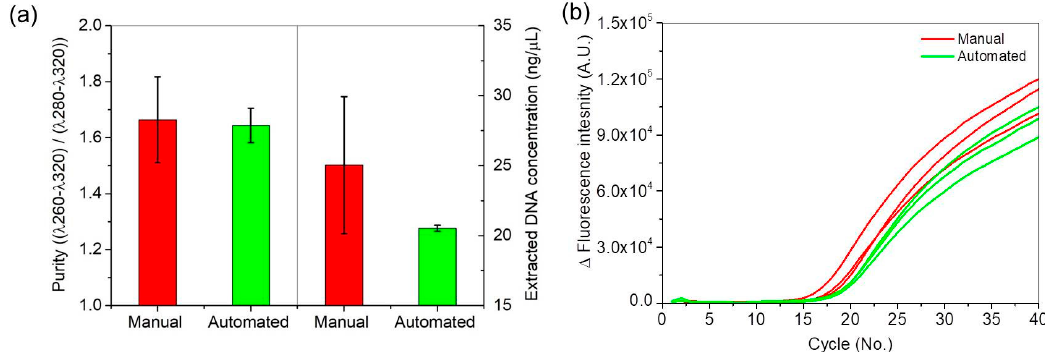
Figure 3. ( a ) DNA purity and concentration of manual and automated extraction samples, and ( b ) variations in fluorescence intensity of manual and automated extraction samples during PCR amplification.